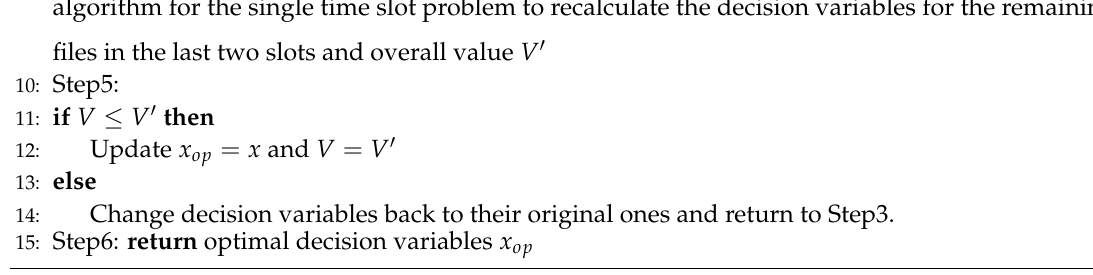
algorithm for the single time slot problem to recalculate the decision variables for the